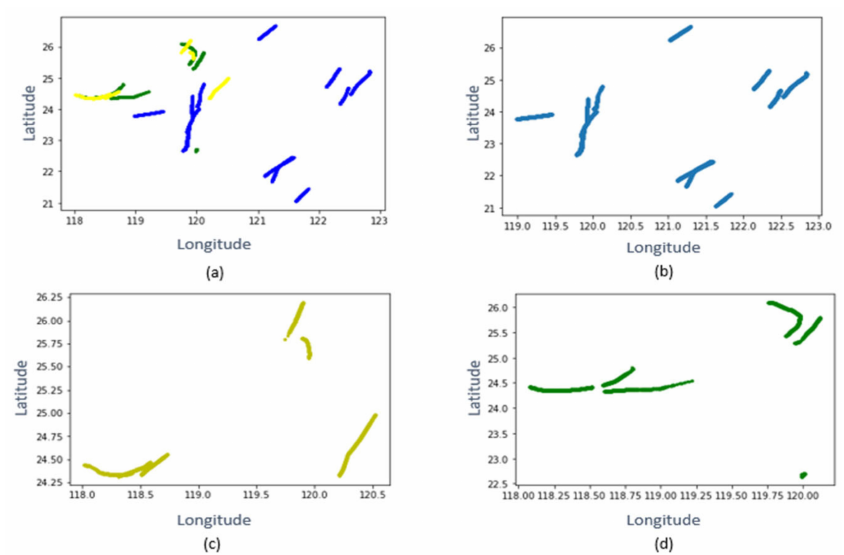
Figure 9. Vessel trajectories through clustering. ( a ) Corresponding trajectory clustering results; Green, cluster 1; Blue, cluster 2; Yellow, cluster 3; ( b ) Vessel trajectory of cluster blue; ( c ) Vessel trajectory of cluster yellow; ( d ) Vessel trajectory of cluster green.